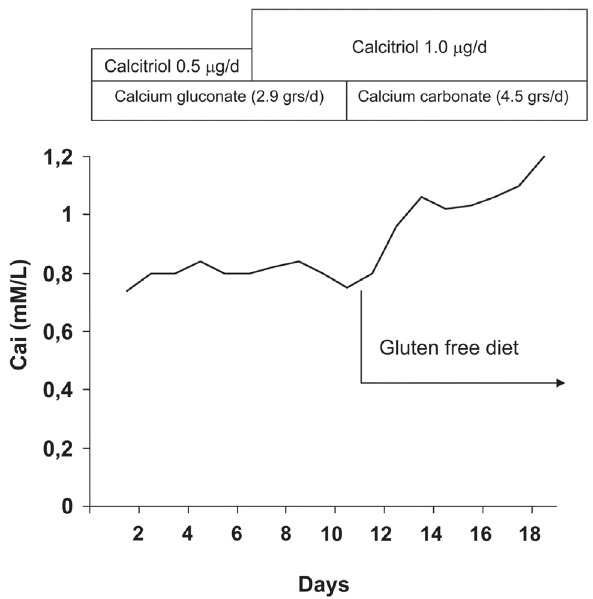
Figure 1 - The effect of a gluten-free diet on the ionized calcium levels in a patient with primary hypoparathyroidism associated with celiac